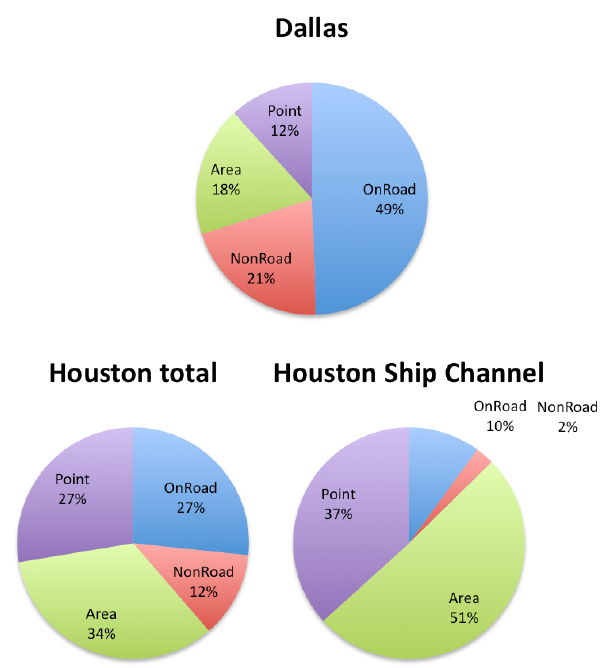
Figure 4. Partitioning of NO x emissions in NEI05-REF for Dallas-Fort Worth (see Table 4 for 4 Fig. 4. Partitioning of NO x emissions in NEI05-REF for Dallas- Fort Worth (see Table 4 for geographic definition), Houston (Ta- geographic definition), Houston (Table 4), and the Houston Ship Channel area (94.96W-95.30W, 5 ble 4), and the Houston Ship Channel area (94.96 ◦ W–95.30 ◦ W, 29.67N-29.85N). 6 29.67 ◦ N–29.85 ◦ N).